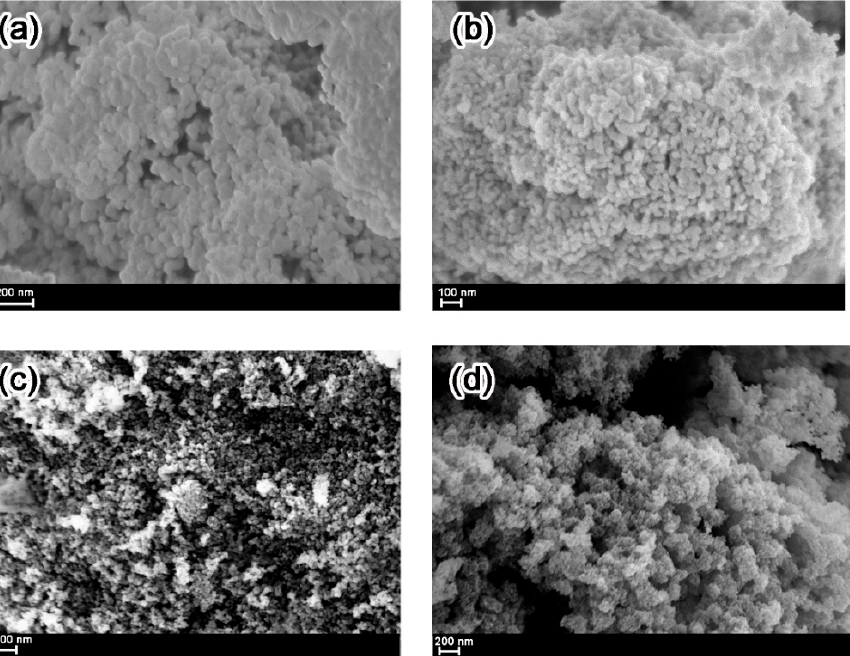
Figure 3. FESEM images of ( a ) NaOH-, ( b ) aloe-vera-, ( c ) dragon-fruit- and ( d ) papaya-extract-me-